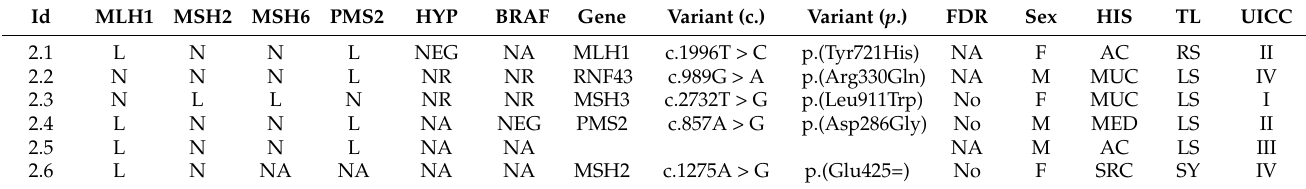
Table 2. Six patients with no pathogenic germline variant but with deficient mismatch repair.